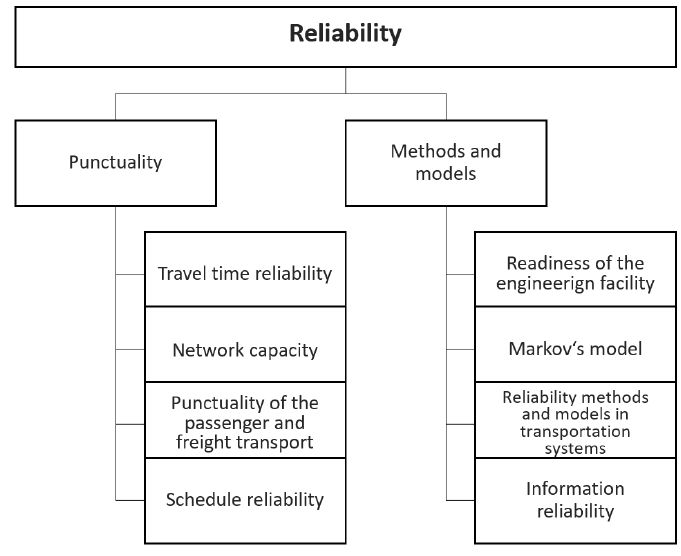
Figure 2. Scheme of literature review regarding reliability.